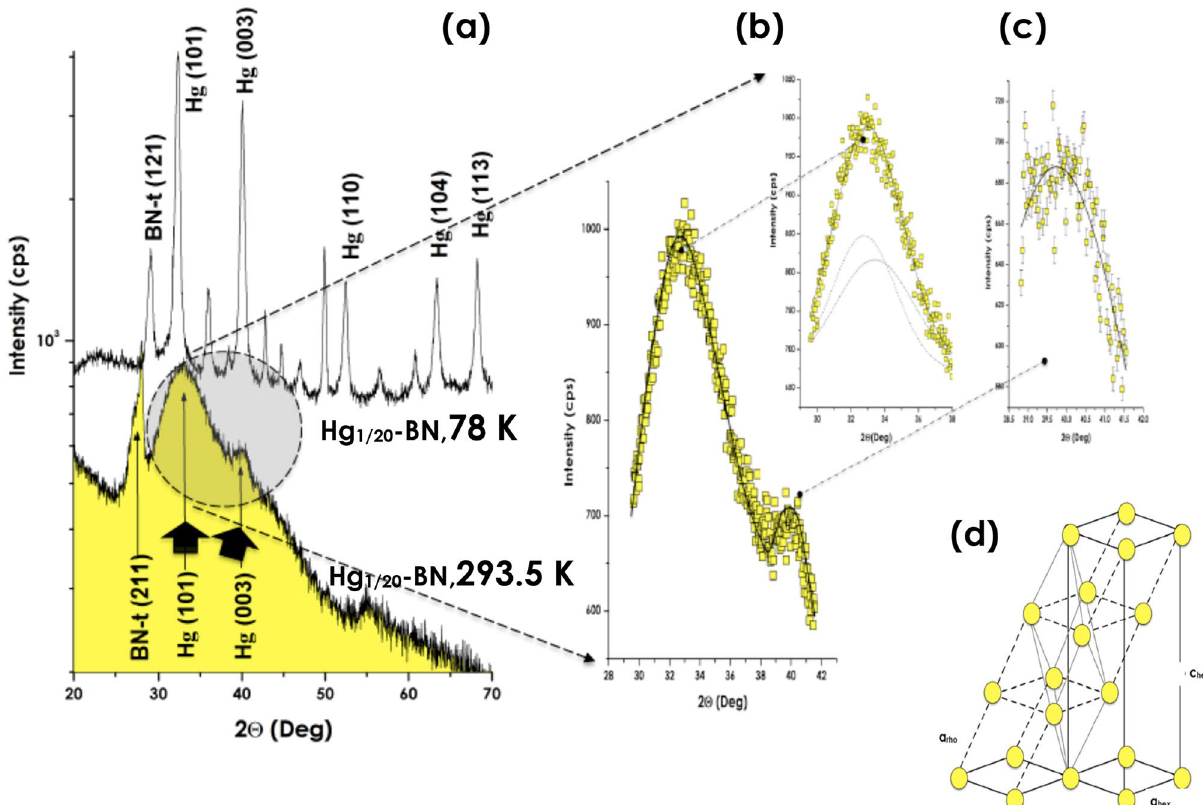
Figure 4. ( a ) Room temperature X-rays diffraction profiles of the Hg 1/20 -BN and its nitrogen temperature. The Inset ( b , c ) displays a magnification of the (101) and (003) Bragg peak inferred to ( d ) Solid a-rhombohedric atomic ordering of encaged nano-scaled Hg with 7–8 ordered atomic